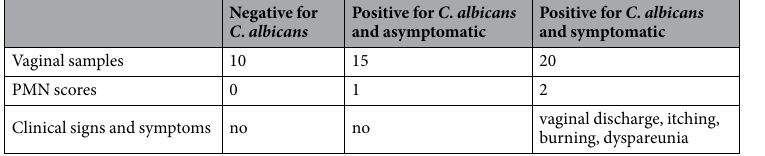
Table 1. Characteristics of women enrolled in the study. PMN scores from 0 to 2 and clinical signs and symptoms from vaginal samples obtained from women enrolled in the study are